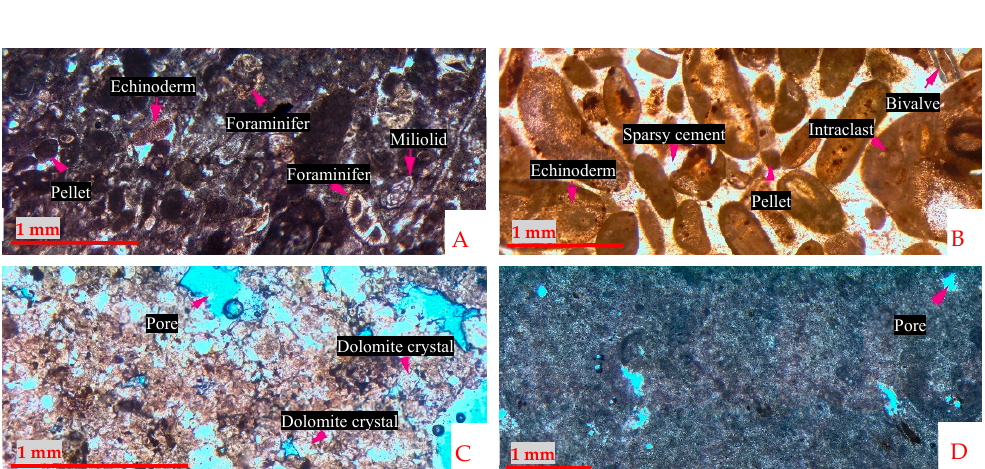
Figure 1. Main sedimentary structural zones of Iran (modified from Aghanabati 2004 [33]) and the location of the studied rock samples.